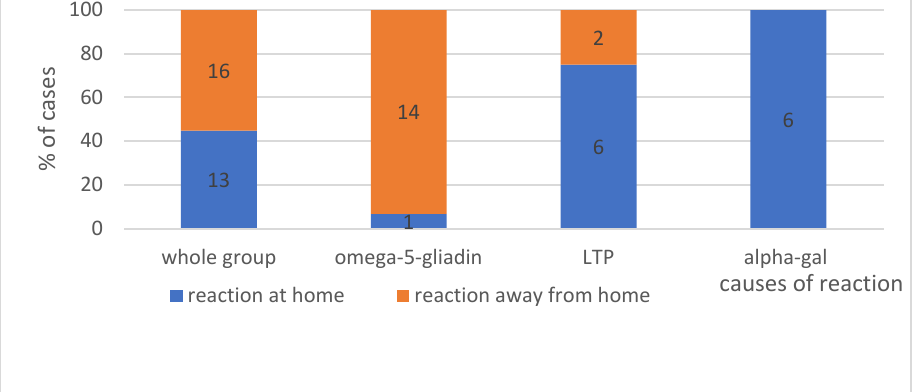
Figure 3. The place of reaction in analysed group, with division into individual causes. Absolute values of numbers of patients are given in the diagram.